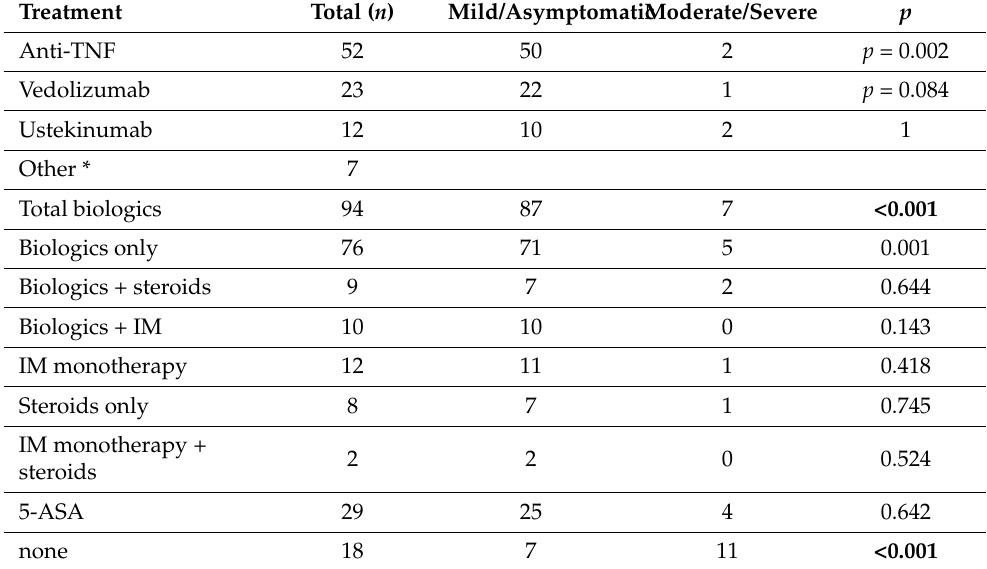
Table 2. IBD treatments in the patient